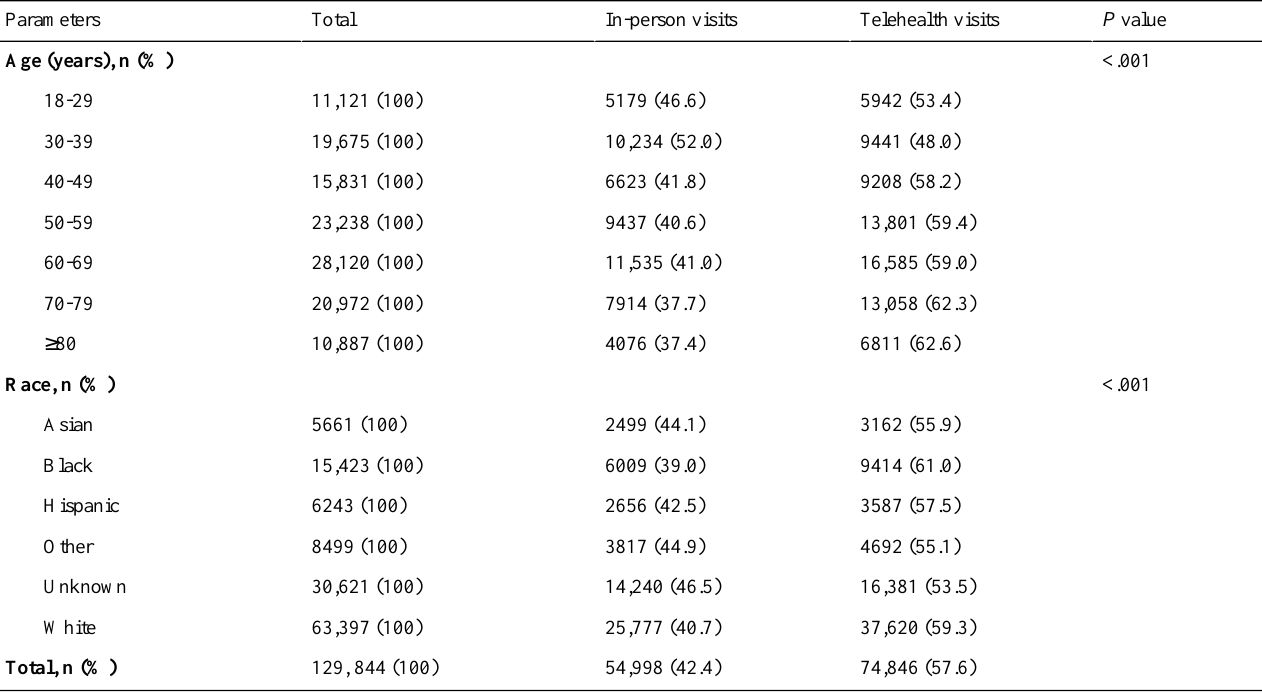
Table 1. Overall usage of in-person and telehealth services from March 2 to June 10, 2020, at a single academic medical center in Boston, Massachusetts, among patients stratified by age and race, recorded at the time of registration (N=129,844).